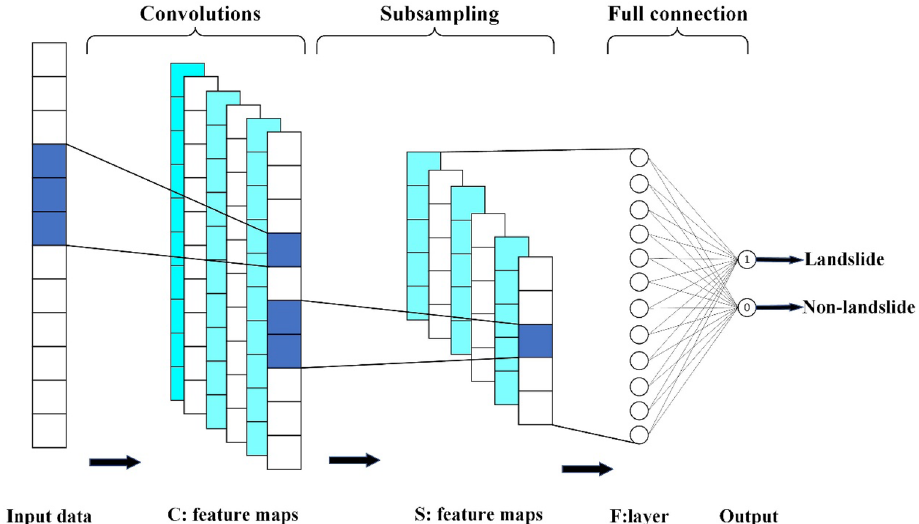
Figure 3. One-dimensional convolutional neural network structure, C represents the convolution layer, S represents the sampling layer, and F represents the fully connected